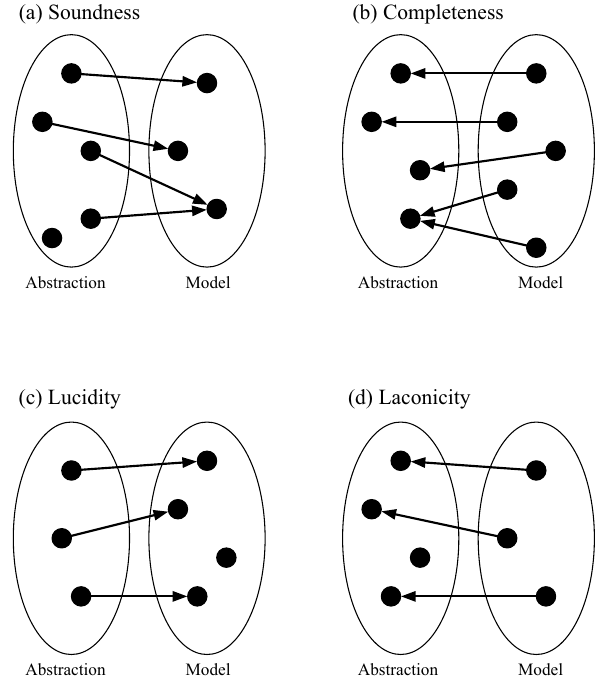
Figure 2. Graphical representation of four ontological properties as mapping between abstraction and model: ( a ) soundness, ( b ) completeness, ( c ) lucidity, and ( d ) laconicity 95